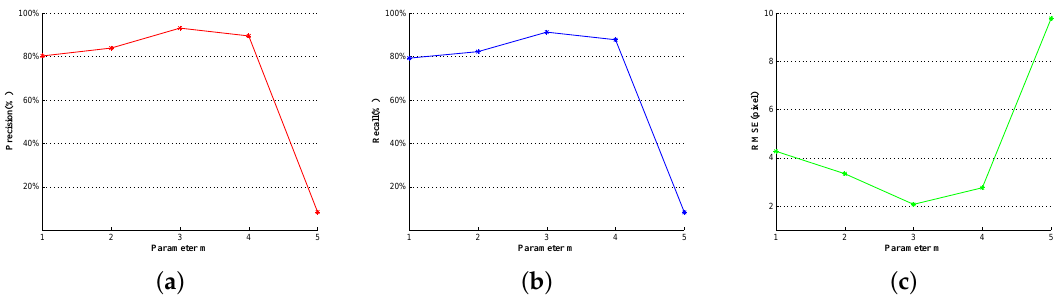
Figure 7. Mean precision, recall and RMSE values of Polynomial fitting with different m s (the order of